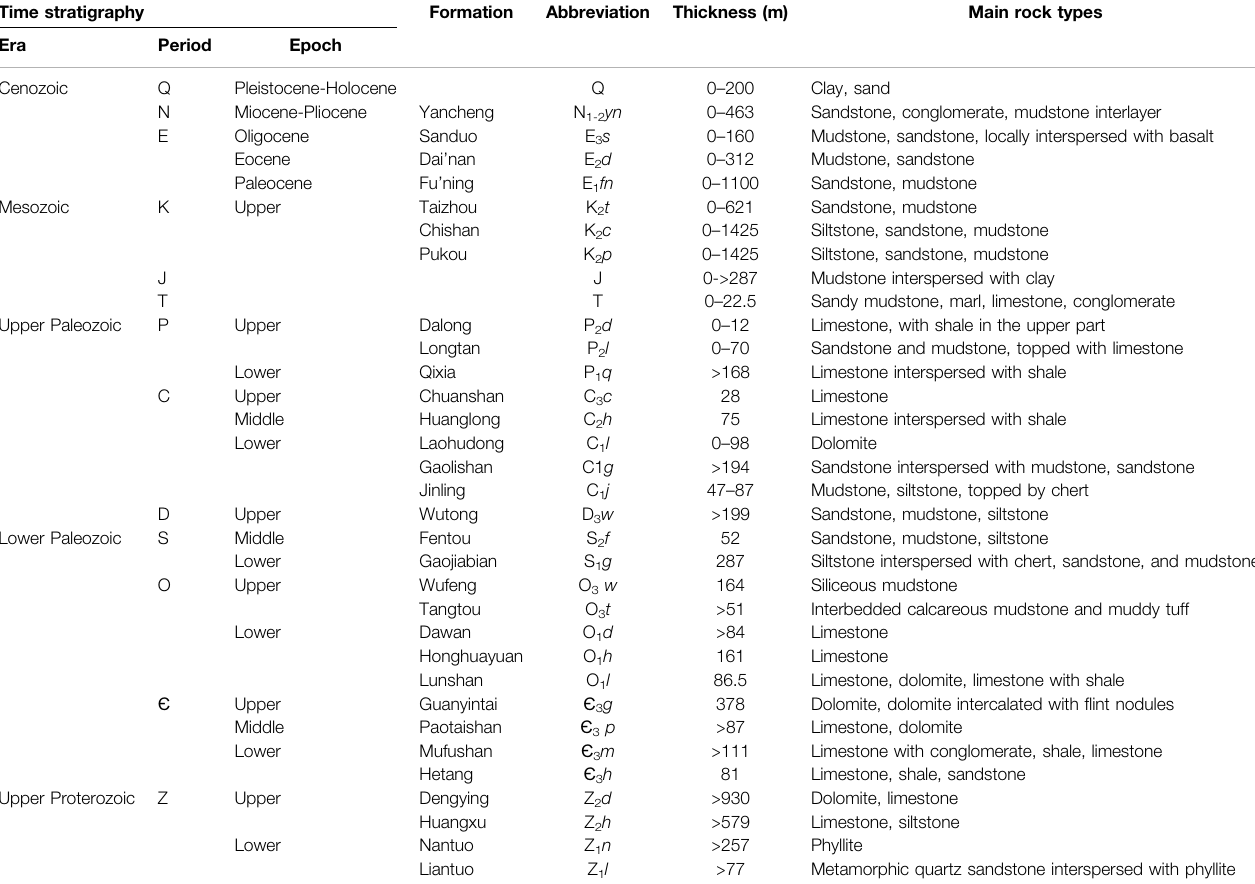
TABLE 1 | Representative strata of the North Jiangsu Basin (Revised from Wang (2020) and oil company